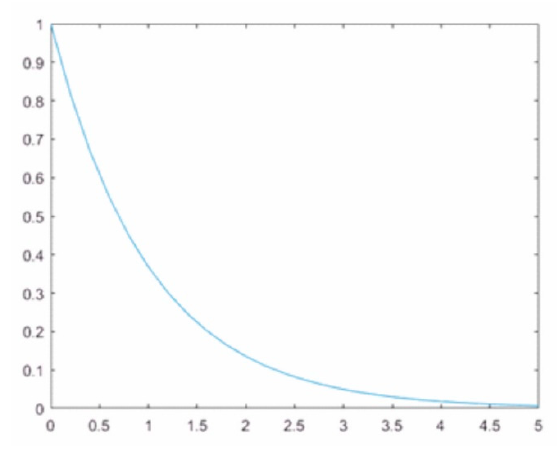
Figure 3. A plot of the function (cid:2869)